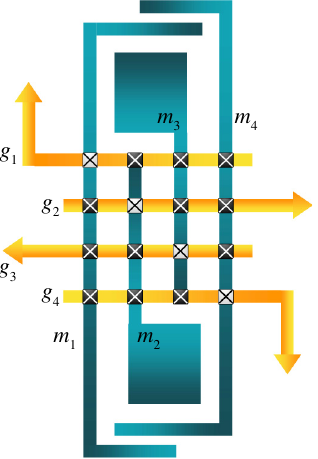
FIG. 9. Schematic for a lattice site [as in Fig. 1(a)] with elec- trostatic combinatorial symmetry. The four matter wires are shown in green, and labeled m 1 – m 4 , and the four gauge wires in orange, labeled g 1 – g 4 . By suitable electrostatic design of the shape of the matter wires, the total effective self-capacitances for each matter wire, and the parasitic capacitances between every pair, can be symmetrized to preserve combinatorial symmetry in the electrostatic